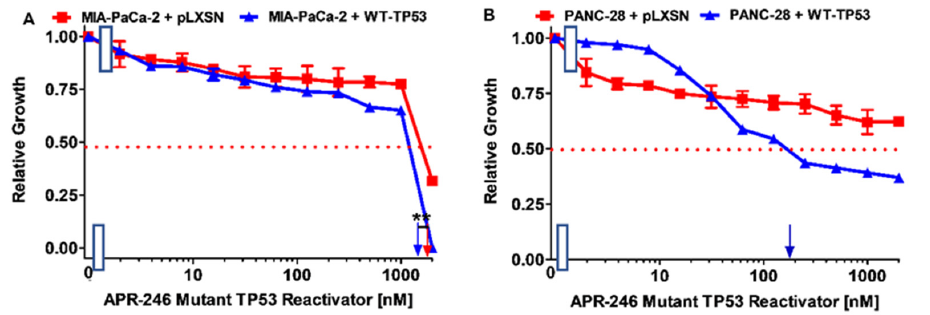
Figure 3. Effects of APR-246 on growth of PDAC cells containing and lacking WT-TP53 and/or mutant GOF TP53. Panel ( A ) MIA-PaCa-2 + pLXSN cells (red squares) and MIA-PaCa-2 + WT-TP53 cells (blue triangles). Panel ( B ) PANC-28 + pLXSN cells (red squares) and MIA-PaCa-2 + WT-TP53 cells (blue triangles). These experiments were repeated, and similar results were obtained. Statistical analyses were performed with Student’s t test on the means and standard deviations of various treatment groups. ** = p < 0.005.